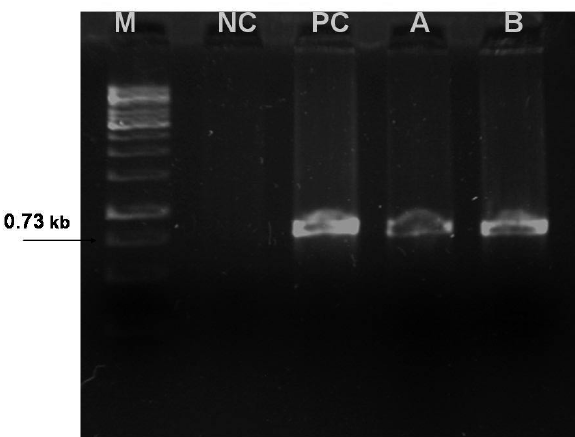
Figure 1. Ethidium bromide stained gel of PCR products directed by X4c and X4e primers, template DNAs were from X. axonopodis pv. malvacearum (NC, negative control), the Xap-19 strain of X. axonopodis pv. phaseoli (PC, positive control), Araxa 1 and Araxa 2 isolates (lane A and B respectively). Molecular weight standard (GeneRuler TM 1 kb DNA ladder, Fermentas) was run in the left lane (M).